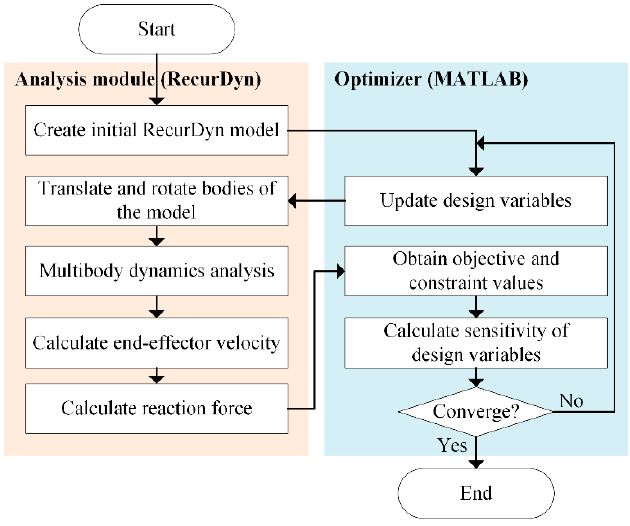
Figure 4. Flowchart of the optimization framework using the analysis module (RecurDyn) and the optimization module (MATLAB).